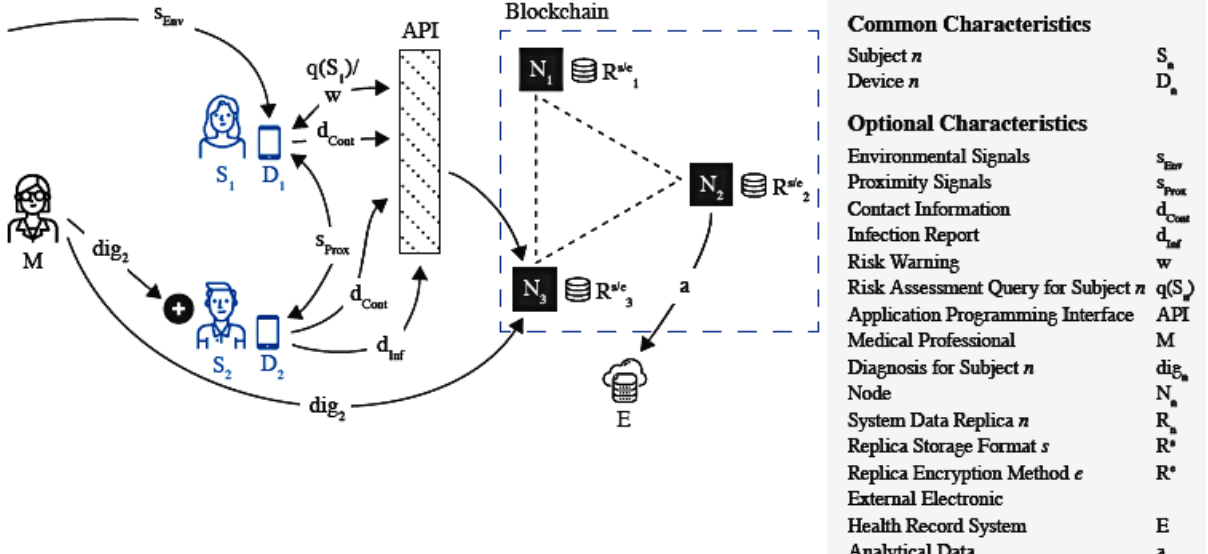
Figure 1. An archetype of a blockchain-based contact tracing environment derived from architectures described in the published literature. EHR: electronic health